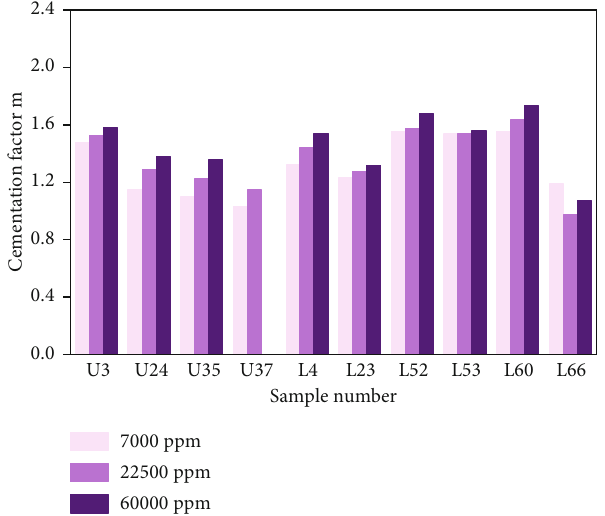
Figure 6: Comparative analysis results of cementation factor in each single sample under three assigned salinities ( a = 1